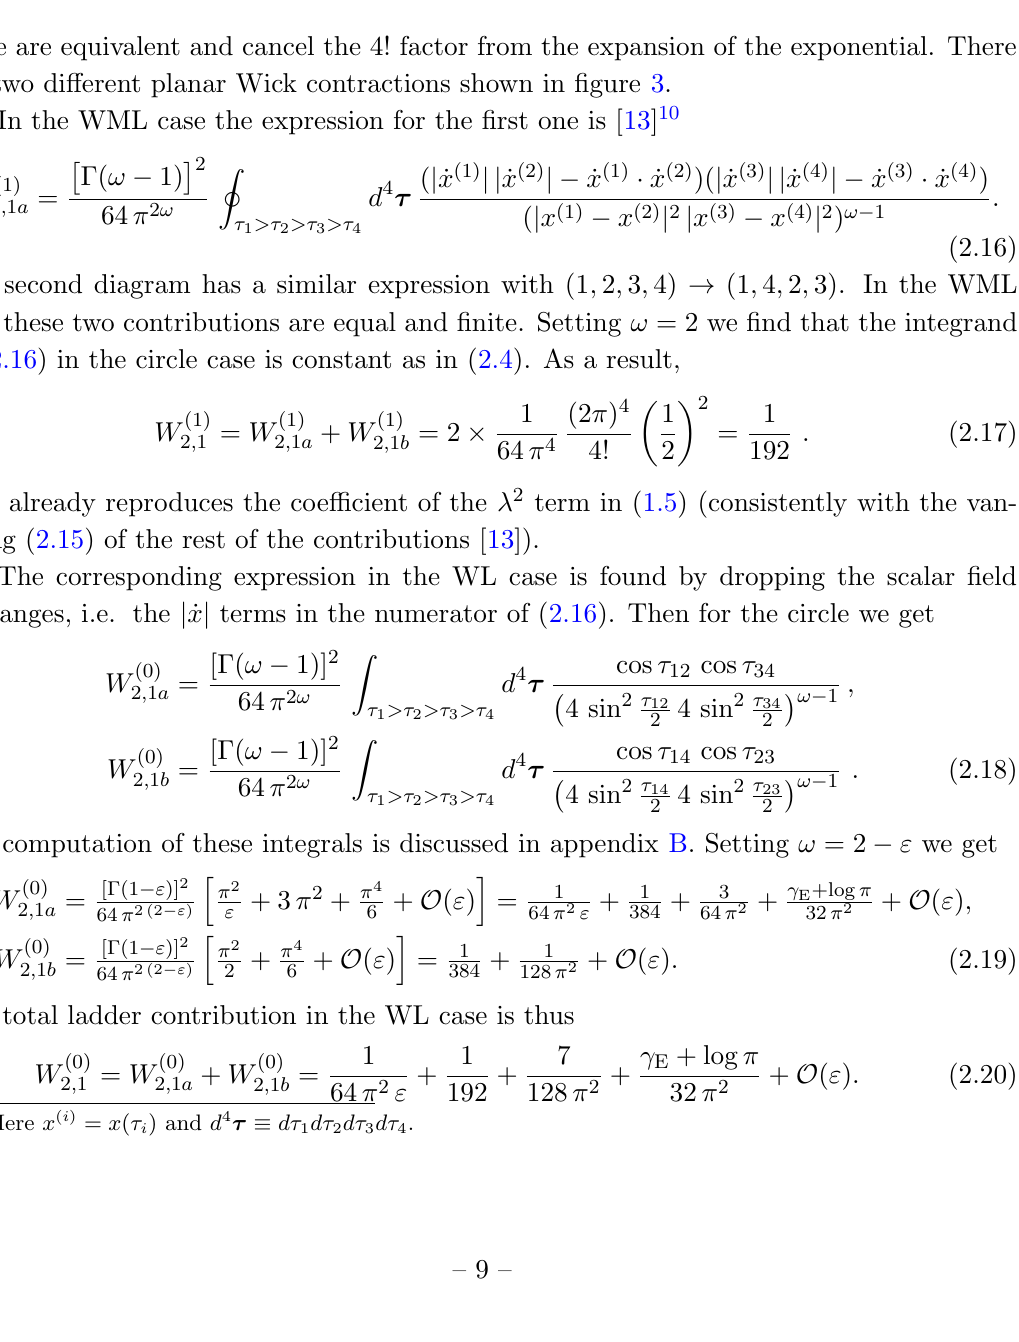
Figure 3 . Two of planar diagrams of ladder type W 2 ; 1 = W ( a ) points (cid:28) 1 ; : : : ; (cid:28) 4 in the WL ( (cid:16) = 0) case. For general (cid:16) one needs also to add similar diagrams with scalar